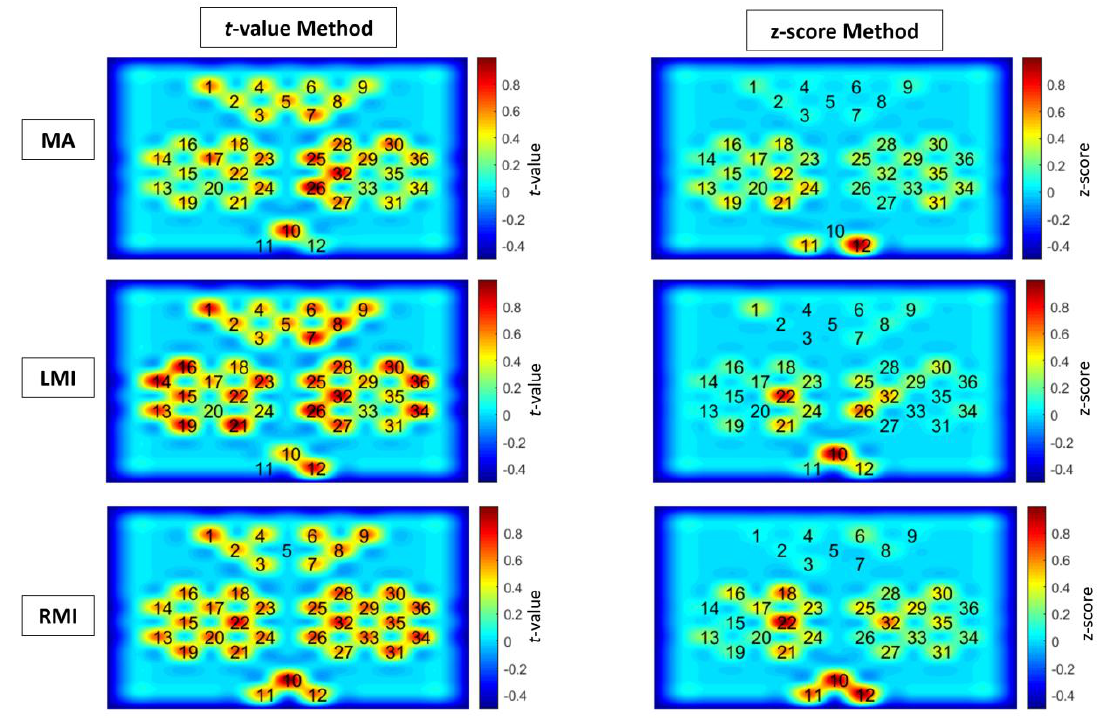
Figure 7. Activation map of t -value and z-score method for LMI, RMI, and MA tasks, for example subject 28.